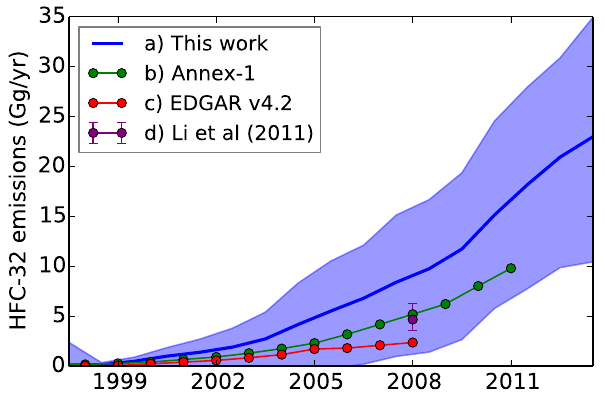
Figure 6. HFC-32 emissions estimates derived from AGAGE ob- servations (blue line and shading, indicating 1 σ uncertainty). The red line shows the global emissions estimates from EDGAR v4.2 and the green line shows the emissions reported to the UNFCCC. The purple point shows emissions estimated for East Asia by Li et al. (2011).